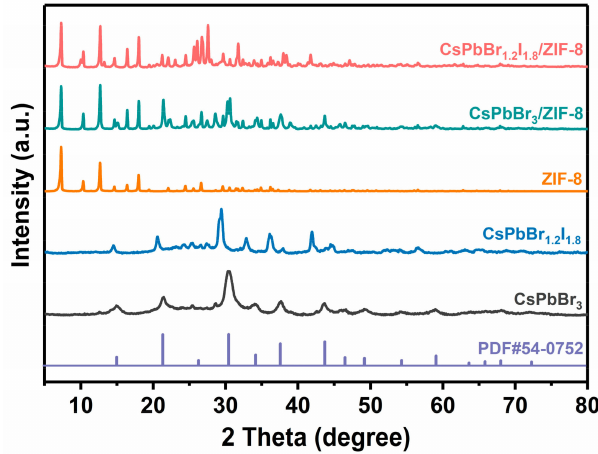
Figure 3. XRD patterns of CsPbX 3 (X = Br, Br 0.4 I 0.6 ) QDs, ZIF-8, and CsPbX 3 / ZIF-8 composites.